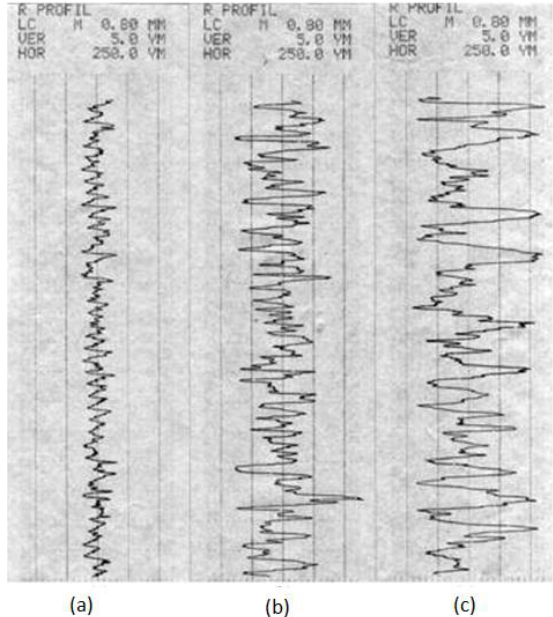
Figure 5: Surface profile at cutting speed (a) 283 m/min, (b) 141 m/min, and (c) 71 m/min. Depth of cut 0.5 mm, and feed rate 0.10 mm/rev (Davim,